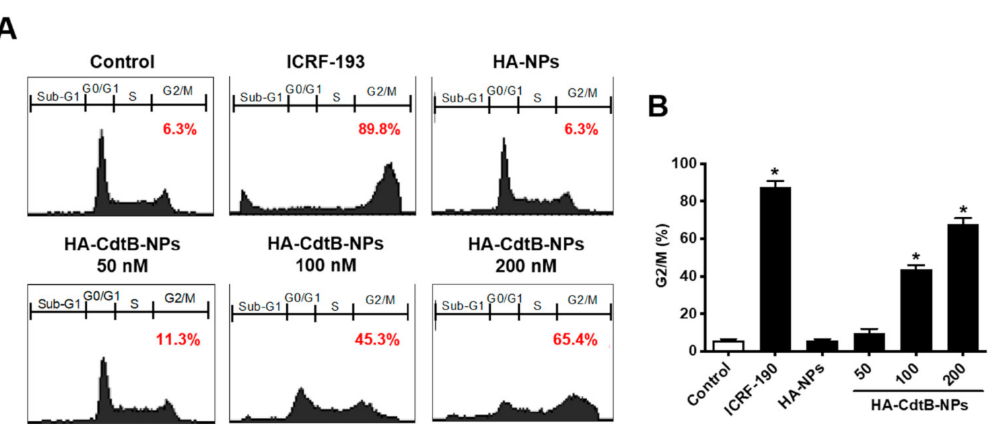
Figure 6. HA-CdtB-NPs induce cell cycle arrest and apoptosis. ( A ) PC3-KD cells were mock-treated, exposed to ICRF-193 or HA-CdtB-NPs (50, 100, and 200 nM), and incubated for 48 h. Cell cycle distribution based on DNA content was analyzed using flow cytometry. ( B ) The percentage of cells at G2/M phase was calculated. Statistical significance was evaluated using one-way ANOVA with post hoc test (* p <